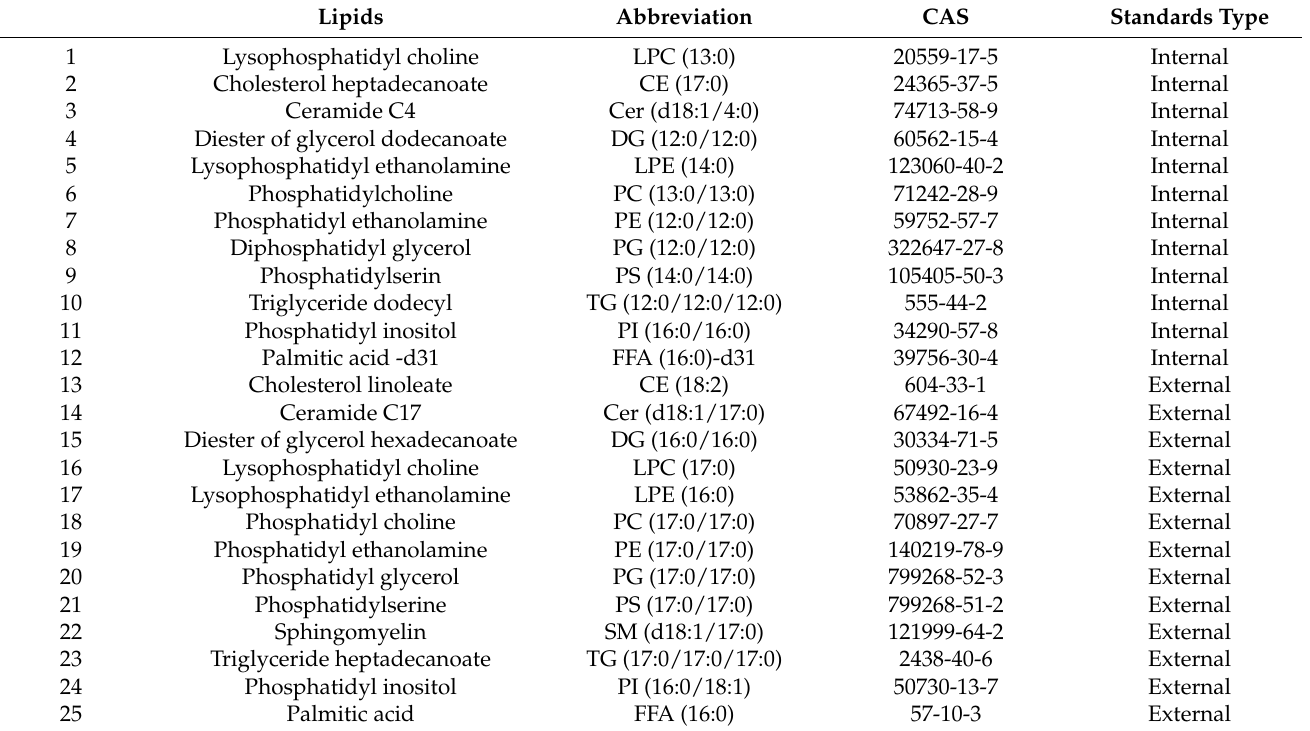
Table 2. Lipid types and information of part of internal and external